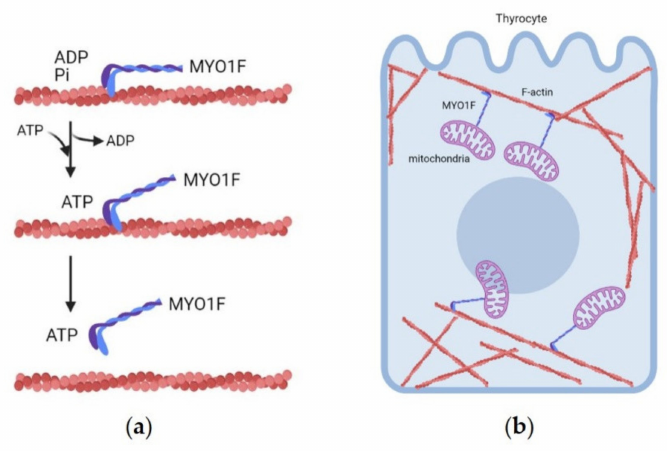
Figure 1. Molecular mechanism of MYO1F movements on actin filaments coordinating organelle transport. ( a ) MYO1F motor domain binds ATP and through the hydrolysis of adenosine triphosphate (ATP) produces the mechanical force along the actin cytoskeleton, ( b ) The figure represents a thyrocyte where MYO1F transports mitochondria along F-actin tracks, driving mitochondria in network. The causative variant p.Gly134Ser is predicted to alter the structure of the ATP binding domain in the molecular motor of MYO1F, blocking ATP hydrolysis and the movement of MYO1F towards actin filaments, with consequent alteration of the mitochondrial network. The figure was created with